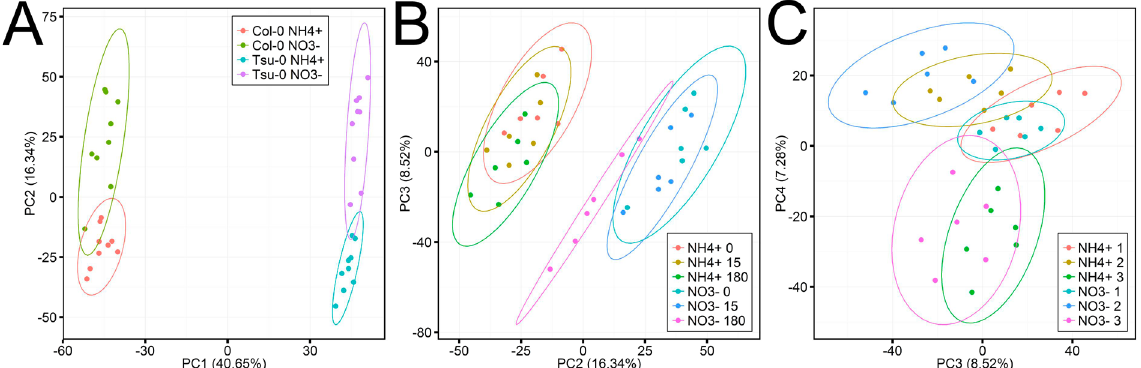
Figure 7. Principal Component Analysis of microarray data of all N-depletion experiments conducted with the accessions Col-0 and Tsu-0. Left: PC1 vs. PC2, data points are grouped for accession and pre-treatment, center: PC2 vs. PC3, data grouped after pre-treatment and time-point, right: PC3 vs. PC4 grouped for replication and pre-treatment.